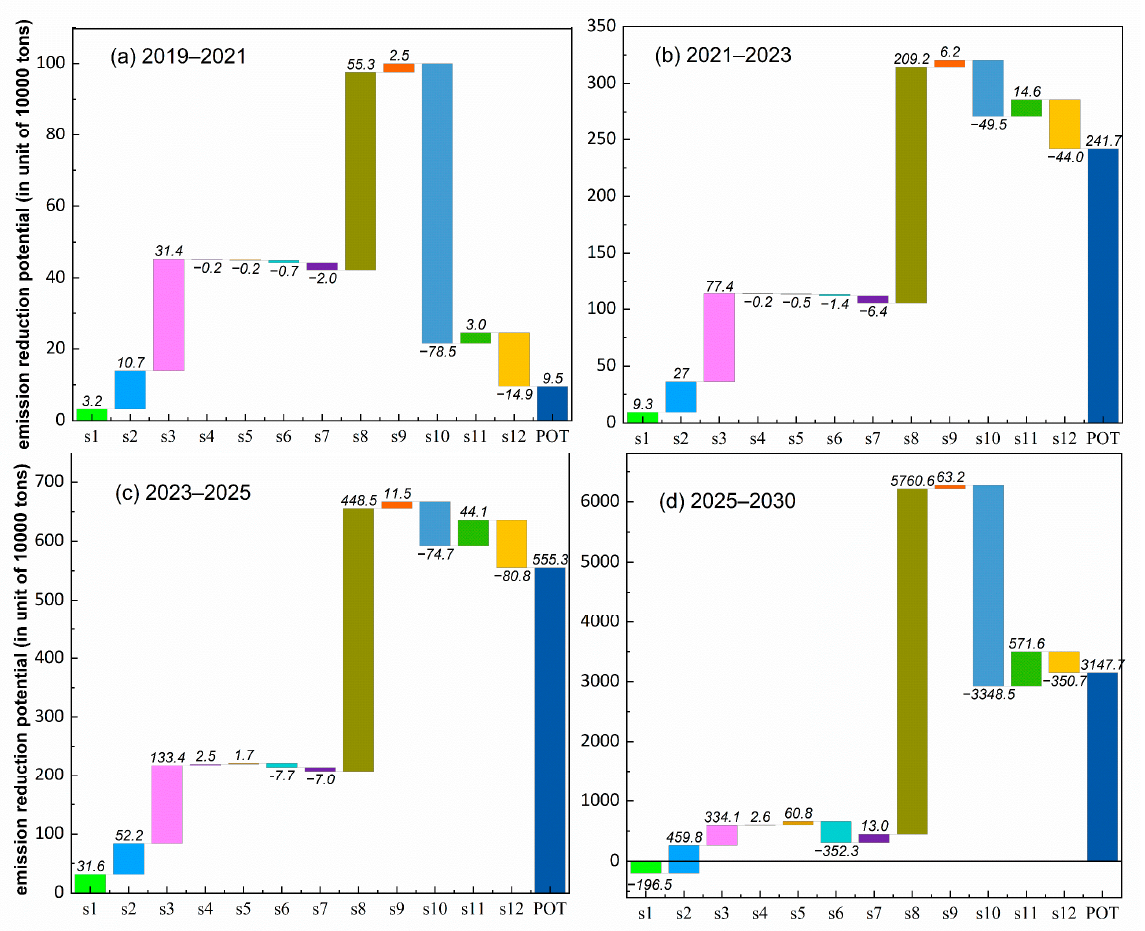
Figure 4. Shenzhen’s emission reduction potential for industrial restructuring between 2019 and 2030. A minus sign represents that industrial restructuring could lead to an increase in carbon emis- sions.